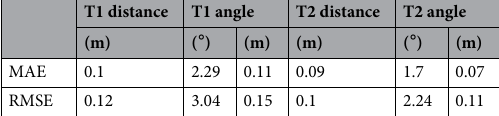
Table 2. Mean absolute errors reported in this